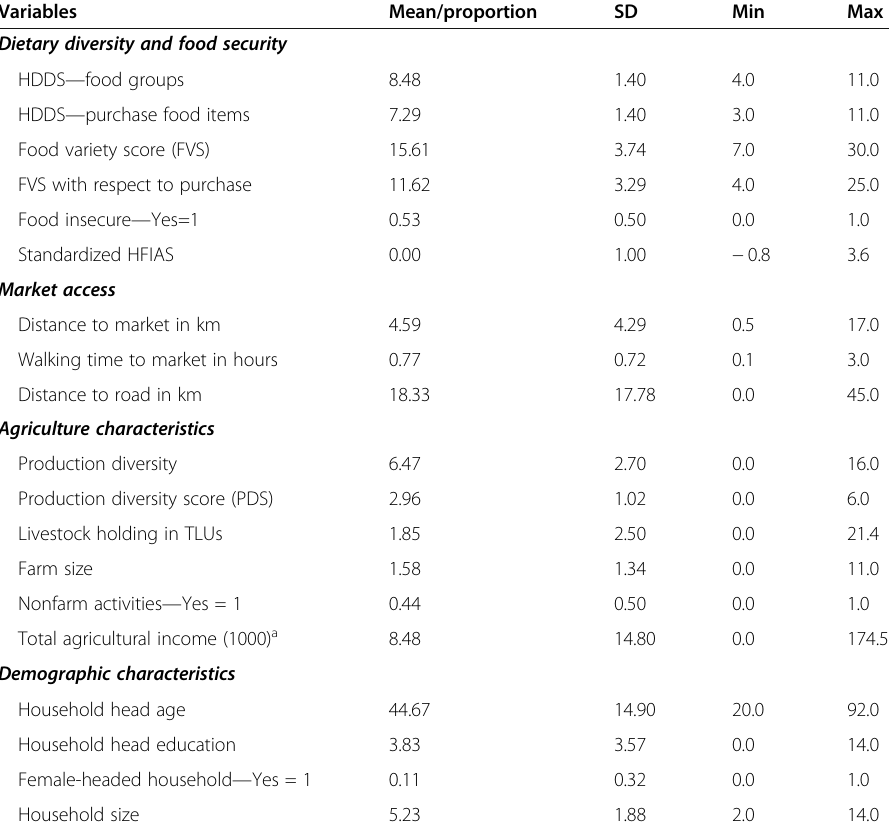
Table 1 Assessed variables and summary statistics for 324 smallholder households